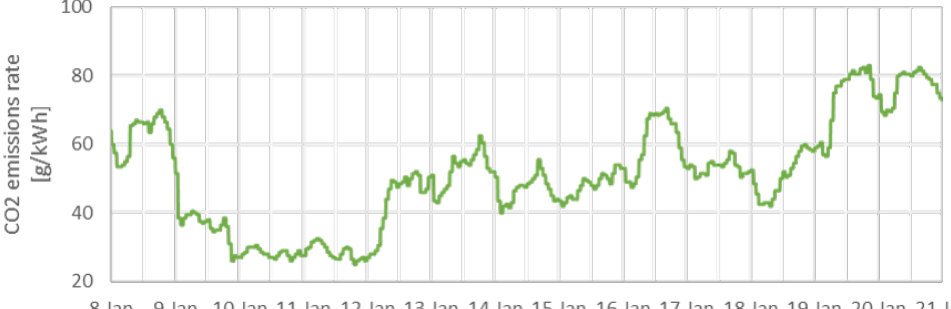
Figure 11. CO 2 emissions rate of the French power system during a two-week period in January 2018.